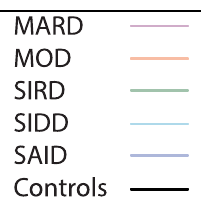
the respective reference cluster. In addition, SAID and the control group is shown forreference.T2Dtype 2diabetes,SAID severeautoimmune diabetes,SIDDsevere insulin-de fi cientdiabetes,SIRDsevereinsulinresistantdiabetes,MODmildobesity- related diabetes, MARD mild age-related